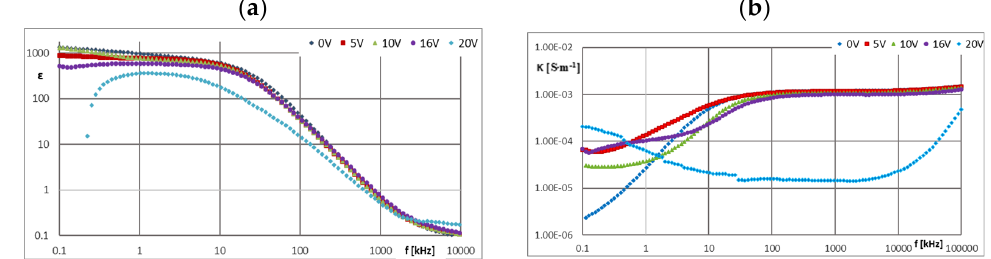
Figure 6. Characteristics: ( a ) ε = f( f ) and ( b ) κ = f( f ) for CJ008 at different values of U.